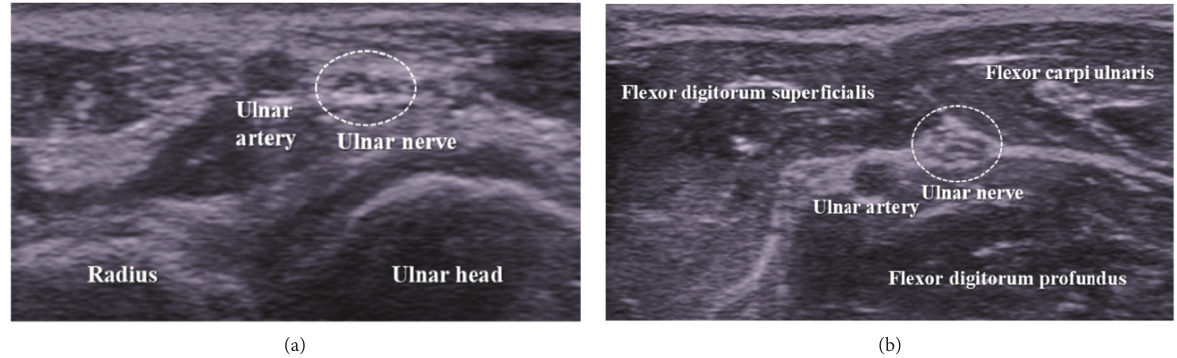
Figure 7: The ulnar nerve is located near the ulnar side of the ulnar artery in the range from the wrist joint to the middle part of the